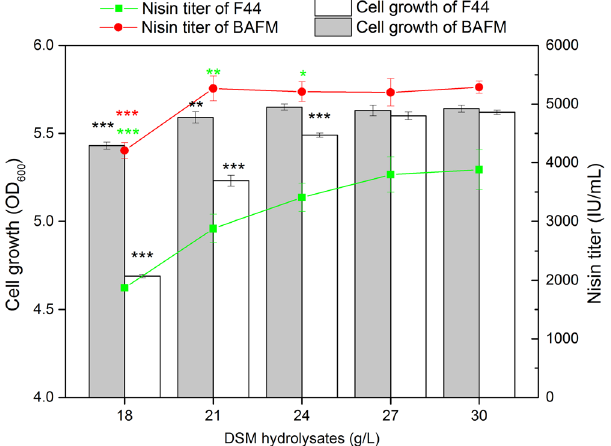
Figure 6. Effect of DSM hydrolysates amount on cell growth and nisin titer of F44 and BAFM. Average data of triplicate experiments were presented. Error bars represent standard deviations from three parallel